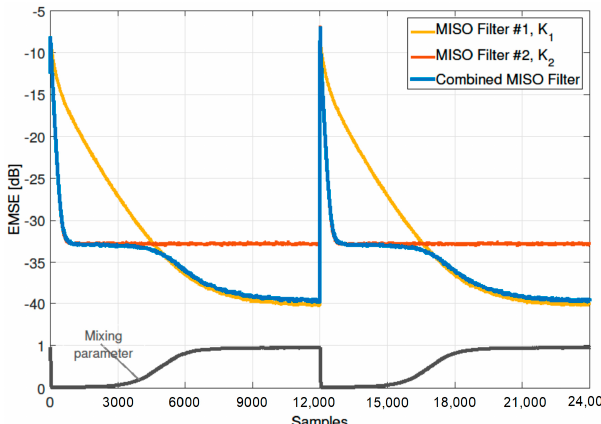
Figure 5. Convergence performance of a combined MISO filter using different projection orders with the related evolution of the mixing parameter λ 0 [ n ]